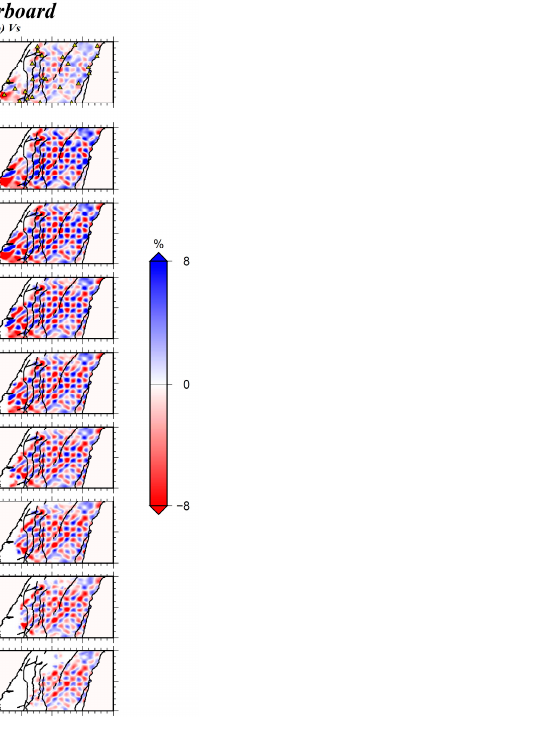
Figure 4. Perturbations of ± 8% of Vp and Vs were added to generate a new 3D velocity model in the form of a checkerboard (grid distance: 10 × 10 km 2 ). Yellow triangles represent the stations. ( a ) Period III checkerboard of Vp. ( b ) Period III checkerboard of